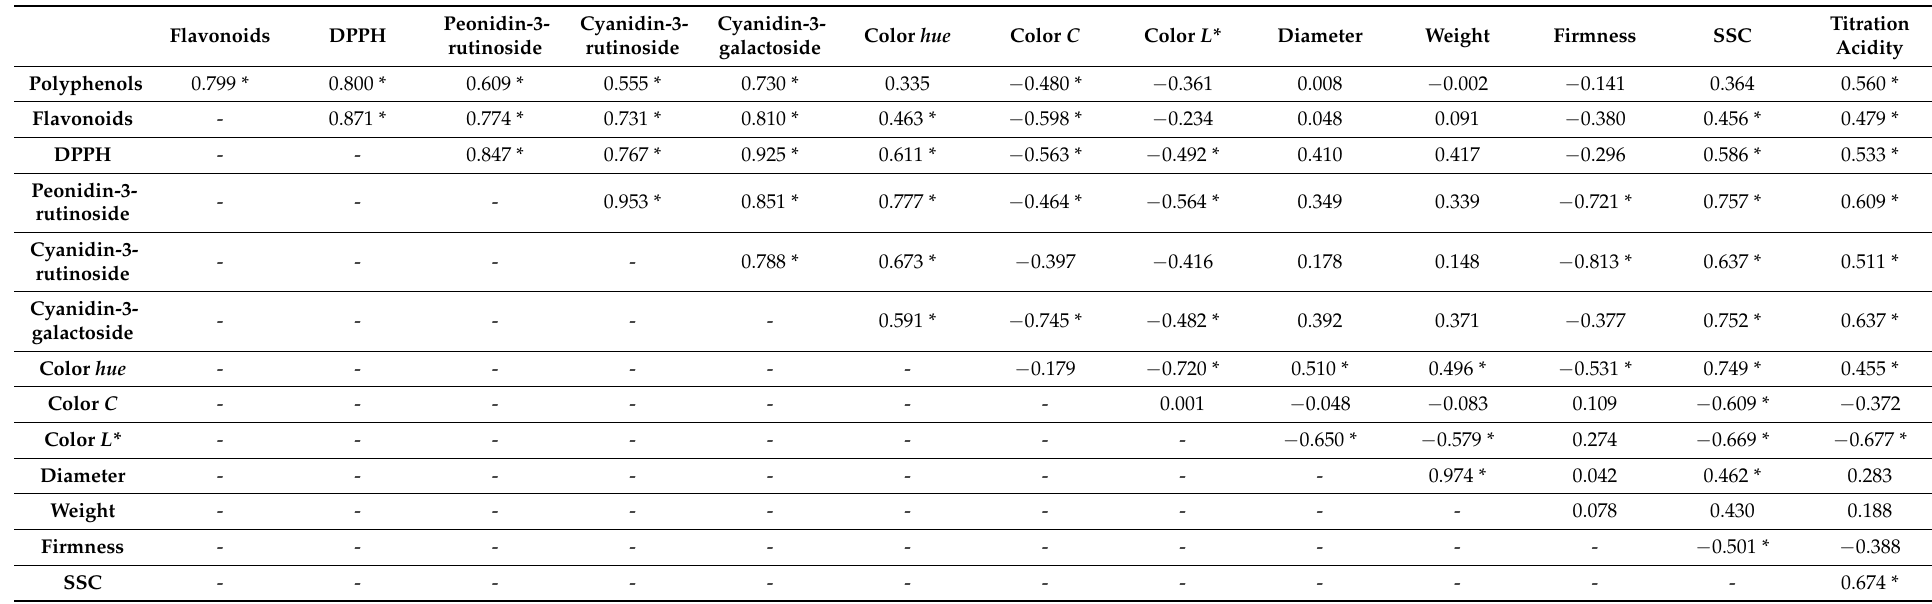
Table 3. Correlation coefficients between some analyzed